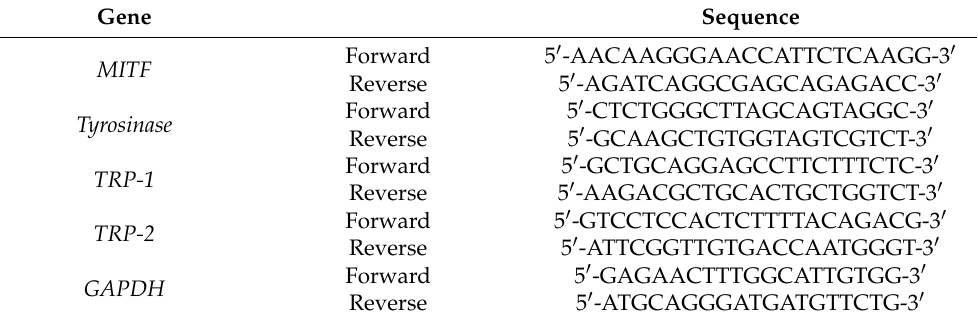
Table 1. Primer sequences for RT-PCR